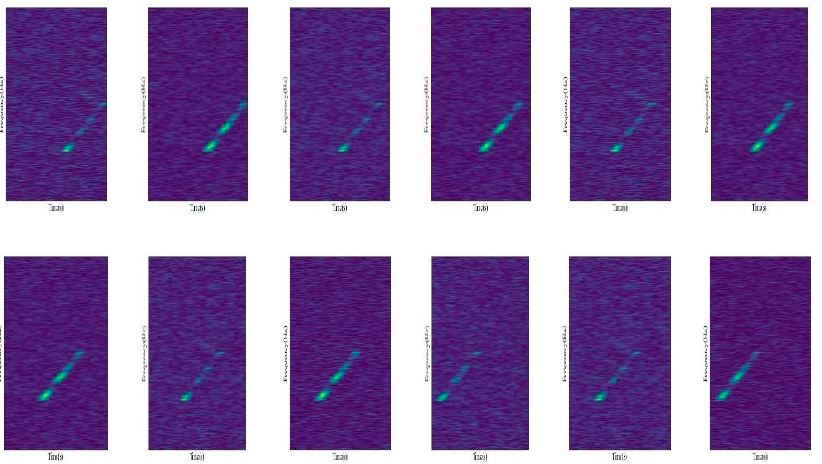
Figure 10. Time-frequency image of the signal to be identified, based on the Kalman filtering and calculating the filtered target state.